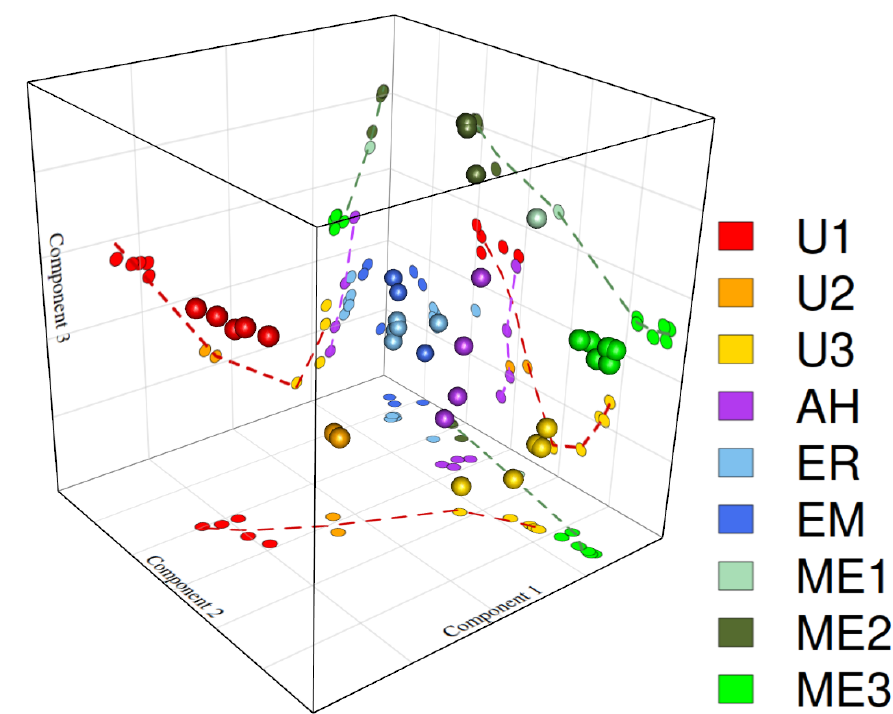
Figure 10. 3D visualization of the clustering of the water samples along the first three principal coordinates. The different colors of large spheres in three-dimensional space and the corresponding colored dots on the projection planes visualize the differences in composition of the groundwater in the Yarmouk Gorge subdivided into nine code groups (Table 1). This plot is based on concentrations in